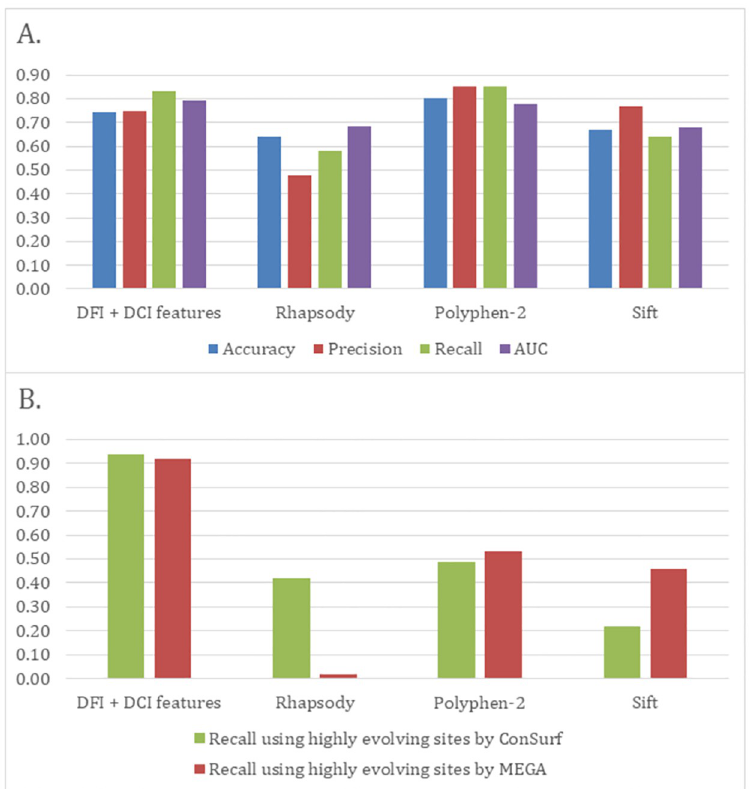
Fig 6. Accuracy of prediction tools tested against 144 enzyme ensemble data. (A) Bar plot showing accuracy, precision, recall, and area-under-the-curve (auc) values for four different methods including our DFI + DCI features. Without using any evolutionary data, our performance matches and may even exceed evolution-based metrics. (B) Recall values for those same metrics tested on fast evolving sites in our data. Higher false negative rates lead to lower recall values for sequence based metrics, but not for DFI + DCI